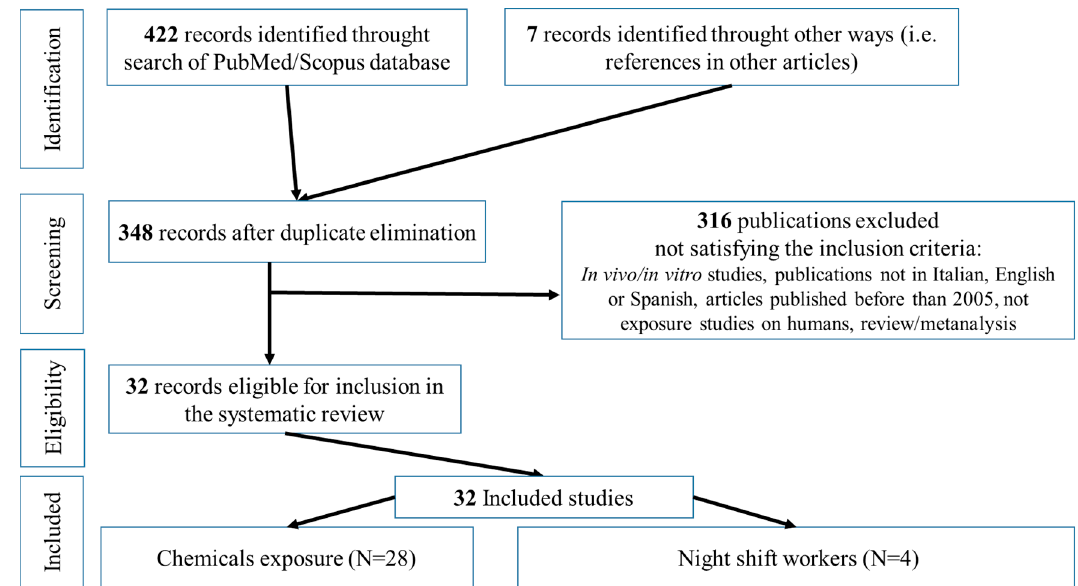
Figure 1. Selection process for articles.